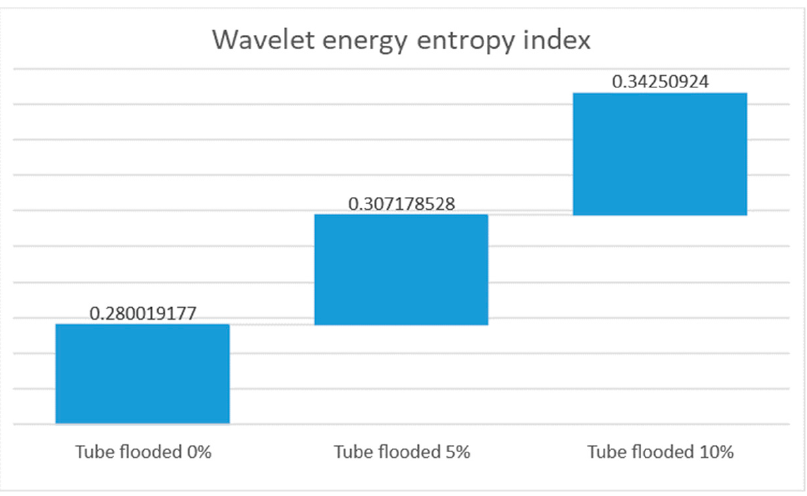
Figure 9. Wavelet energy entropy for the experiment setup in a tube dry and flooded.